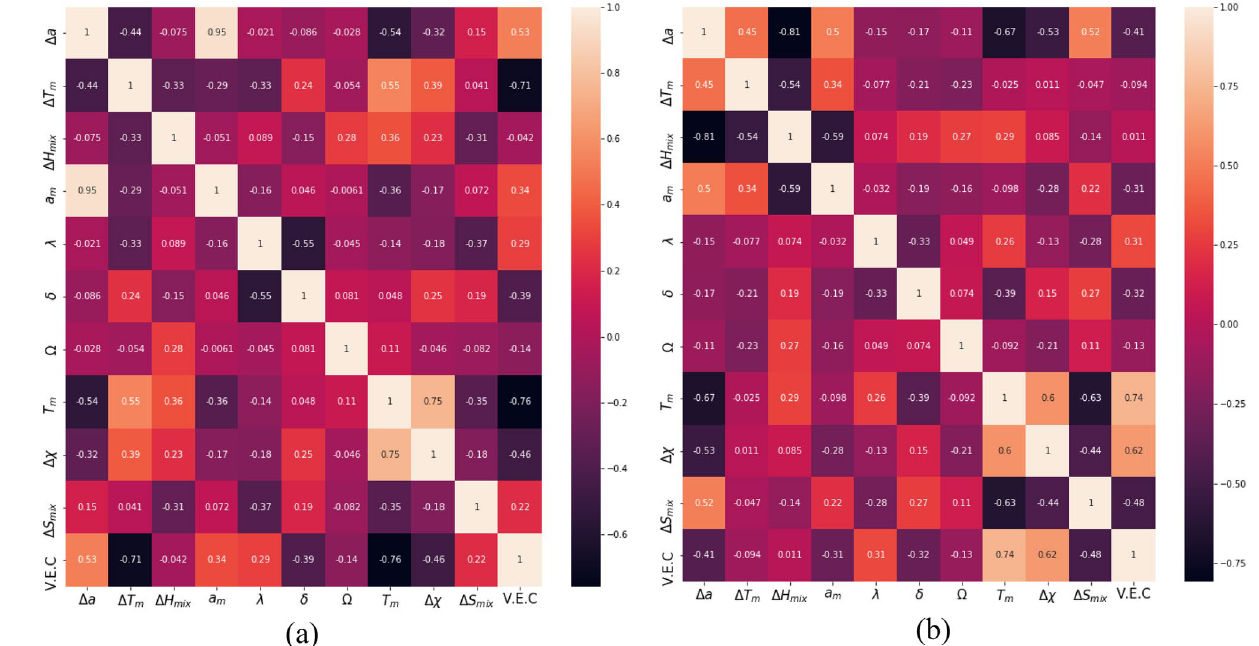
Figure 1. (a) PCC for data with both refractory and non-refractory alloys, (b) PCC for data with only refractory alloys. A value close to 1 or − 1 indicates positive or negative correlation,